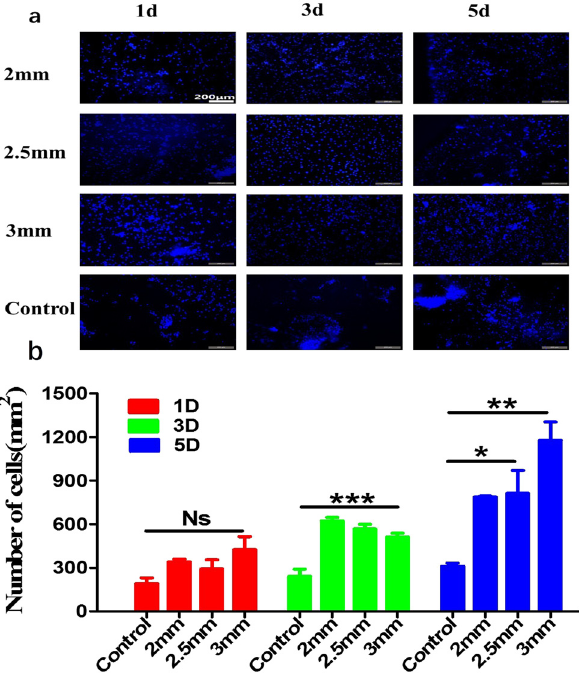
Figure 7: Schwann cells culture. ( a ) Immuno fl uorescence images of GG/ST sca ff old cocultured with RSC96 cells for 1d, 3d, and 5d. ( b ) Statistics of cell count results related to immuno fl uorescence. * p < 0.05, ** p < 0.01 and *** p < 0.001 by one - way ANOVA